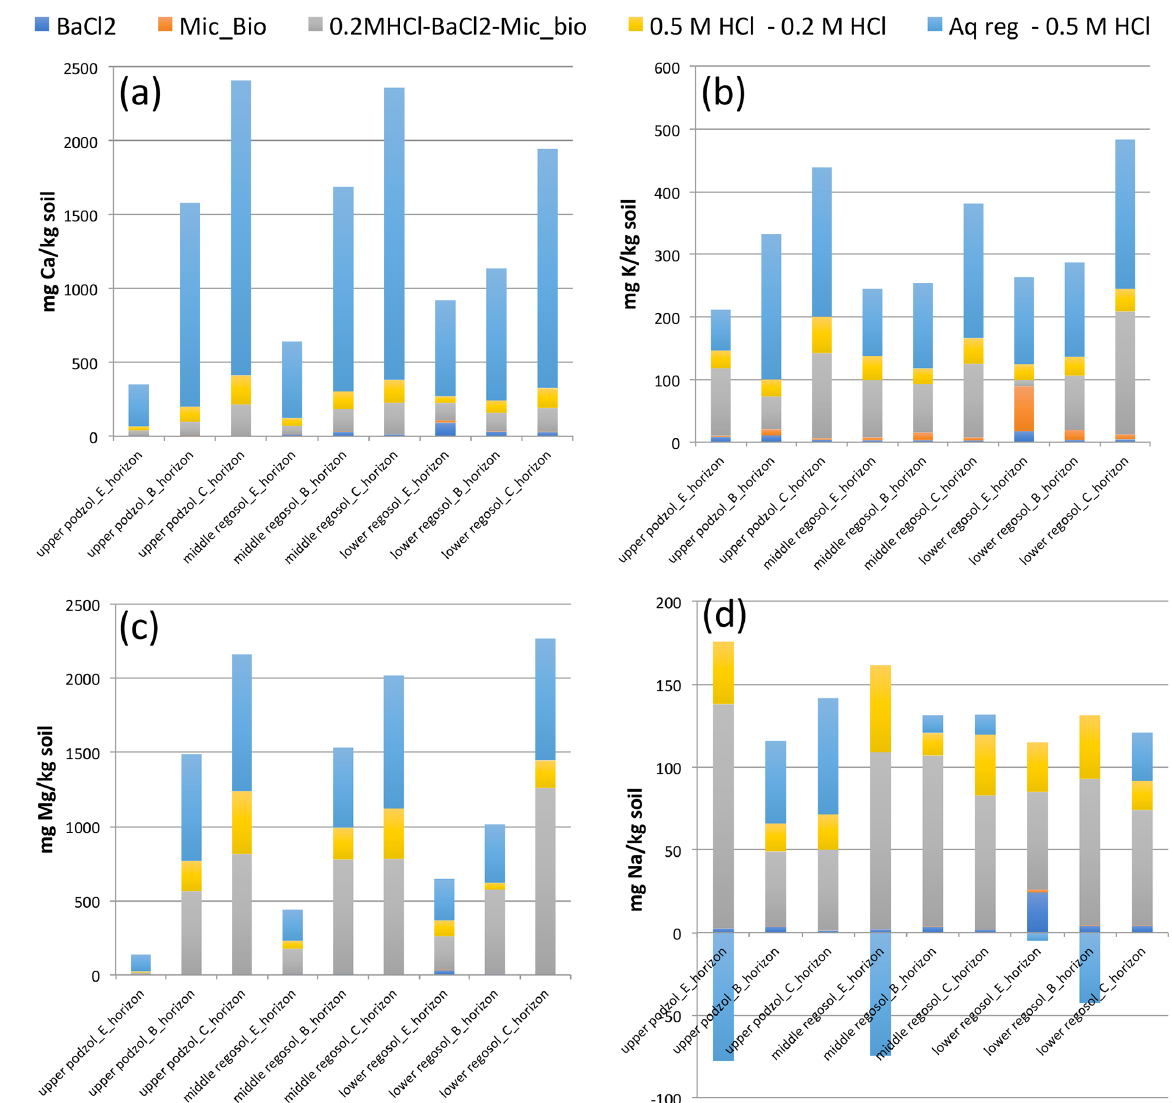
Figure 2. Base cation pool sizes of calcium (a) , potassium (b) , magnesium (c) , and sodium (d) across three soils and three soil horizons ob- tained from soil extraction (BaCl 2 extractions), differences between extractions (aqua regia, 0.5 and 0.2M HCl extractants) and extrapolated estimates (Mic_Bio – microbial biomass; estimated from soil organic carbon